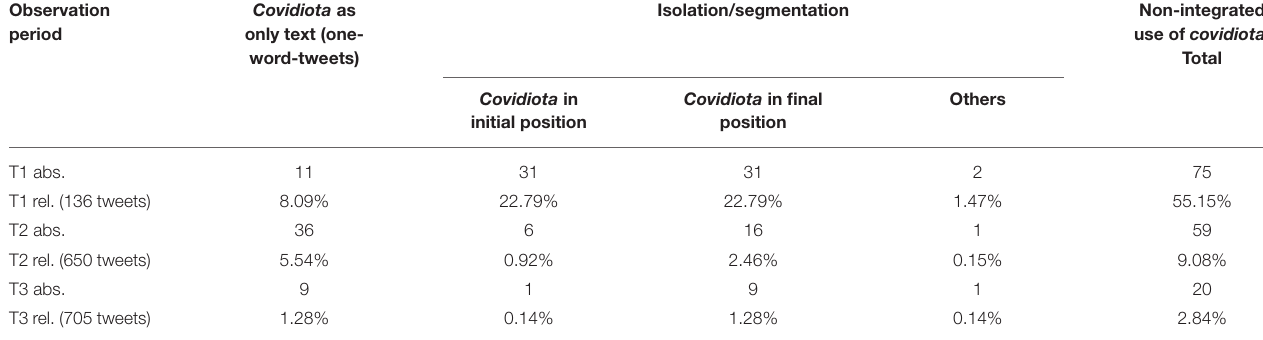
Covidiota as only text